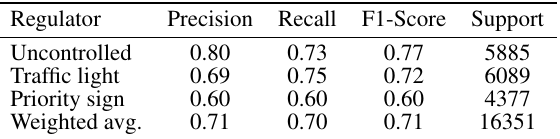
Table 2. Results of the arm rule detection on sequence level. Regulator